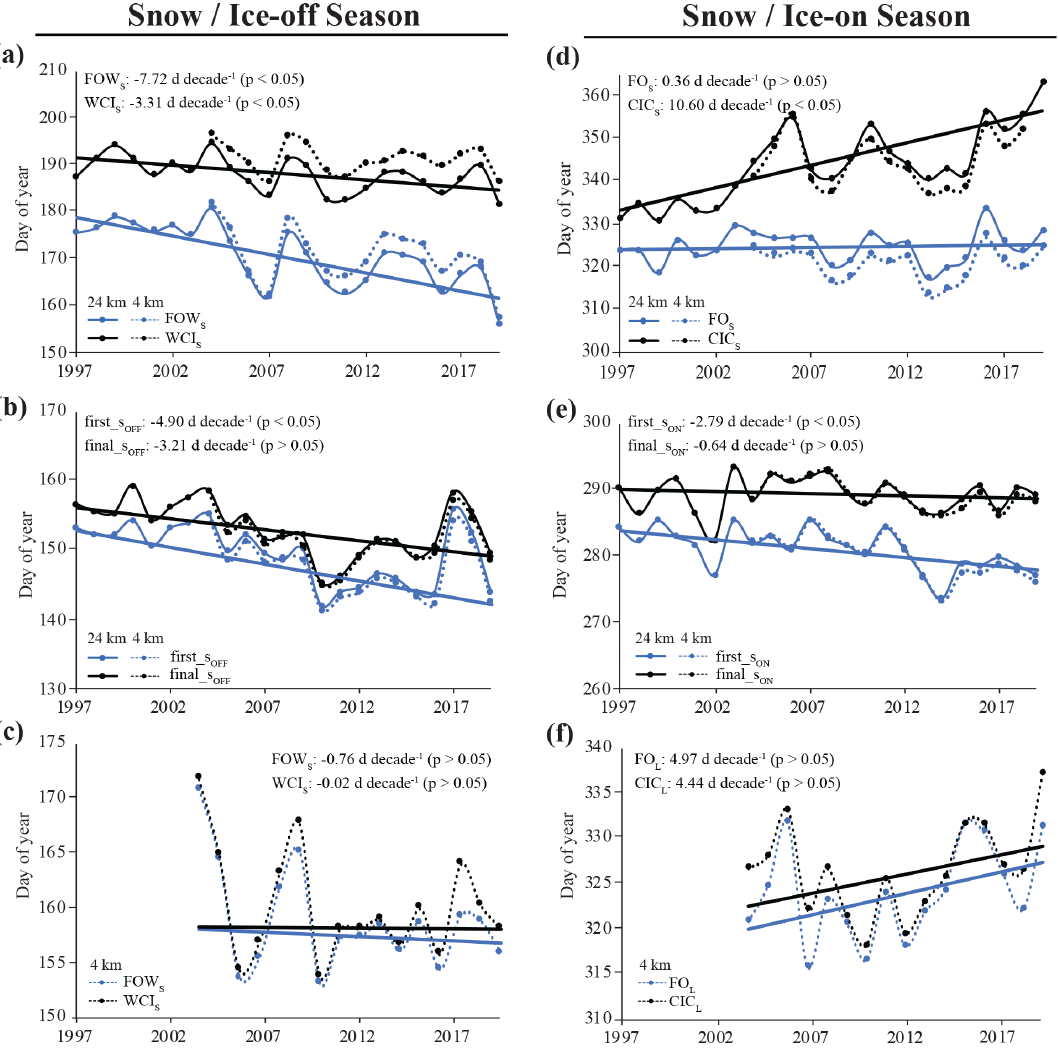
Figure 4. Mean 24km (1997–2019) and 4km (2004–2019) (a) IMS sea ice first open water (FOW S ) and water clear of ice (WCI S ), (b) first snow-off (first_s OFF ) and final snow-off (final_s OFF ), (c) lake ice first open water (FOW L ) and water clear of ice (WCI L ), (d) sea ice freeze onset (FO S ) and continuous ice cover (CIC S ), (e) first snow-on (first_s ON ) and final snow-on (final_s ON ), and (f) lake ice freeze onset (FO L ) and continuous ice cover (CIC L ). Sen’s slope and significance are indicated for each phenology parameter using the 24km IMS product. Note that for lake ice, only the 4km IMS product was used in this